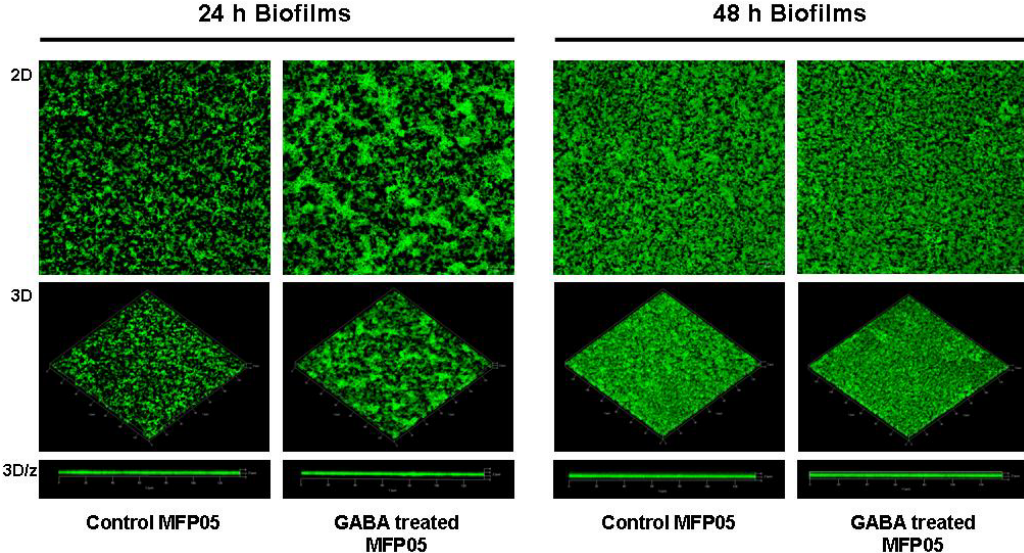
Figure 4. Effect of GABA (10 − 5 M) on the biofilm formation activity of P. fluorescens MFP05 on glass slides. 2D, 3D and 3D/z figures resulting from confocal laser scanning observations were realized after 24 and 48 h of biofilm